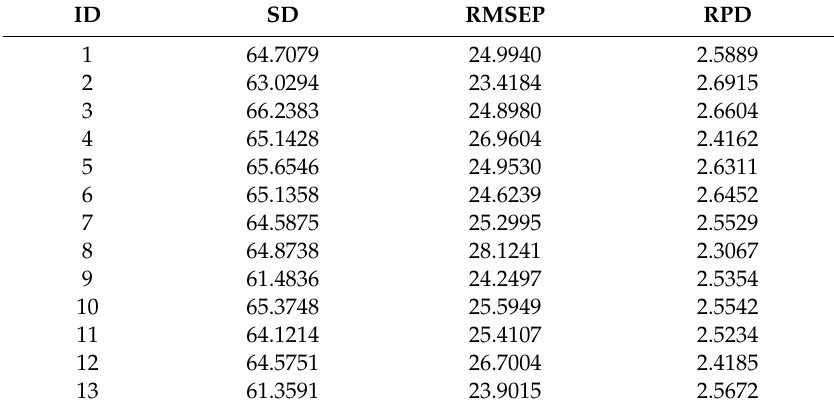
Table 4. Ratio of prediction to deviation (RPD) value of the original tilting image and the restored tilting